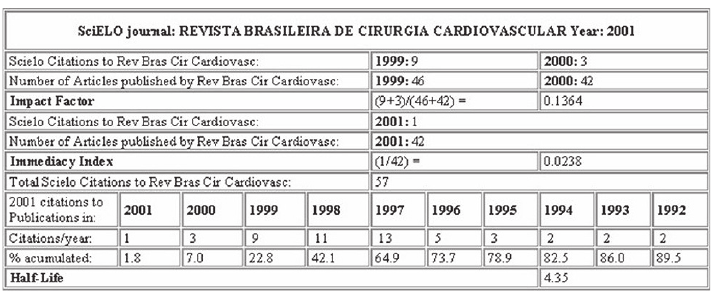
Table 1. Impact Factor, Immediacy Index and Half Life as measured by using SciELO database.